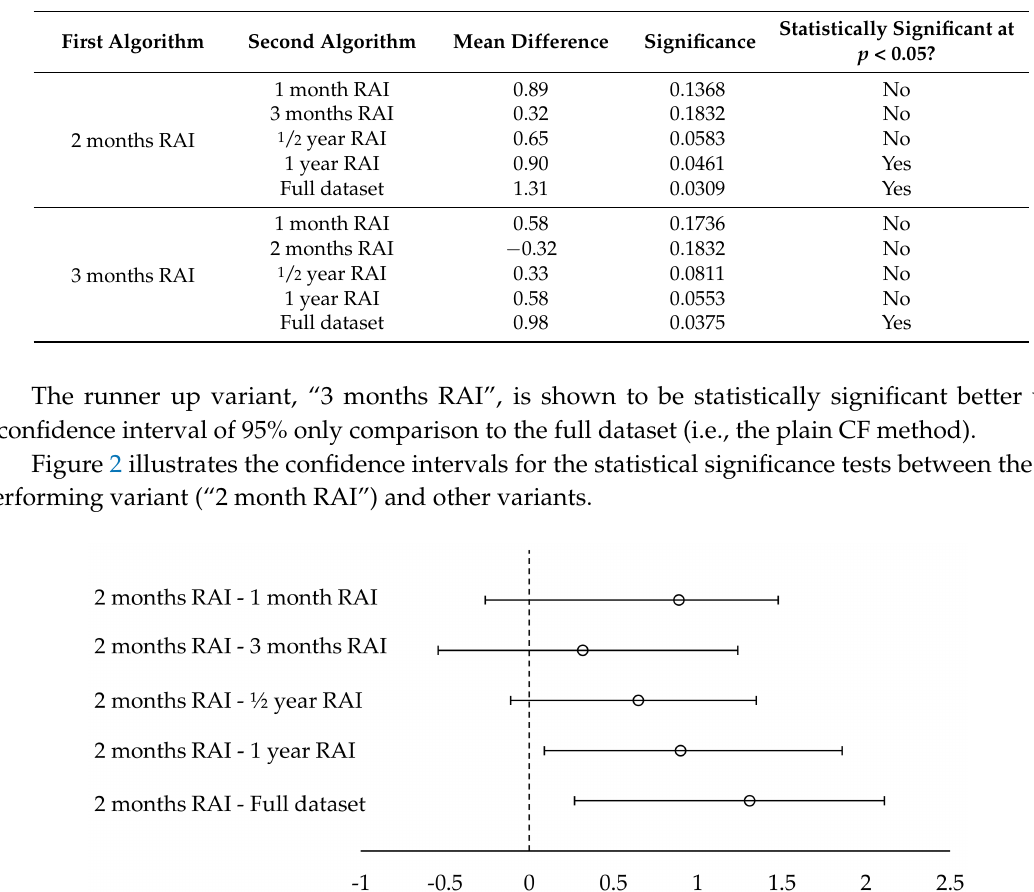
Table 1. Statistical significance tests for the results of the first experiment.